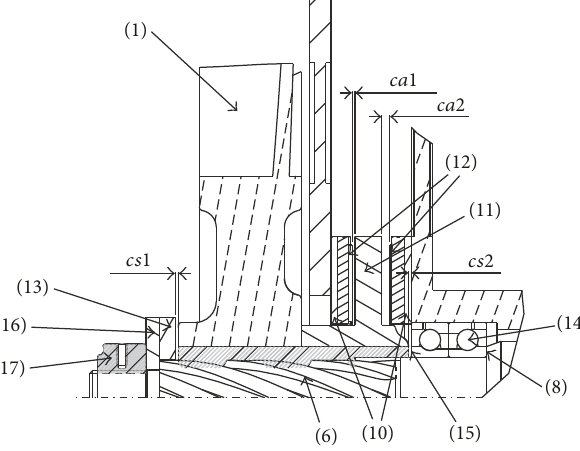
Figure 3: Clearances between the components of the support